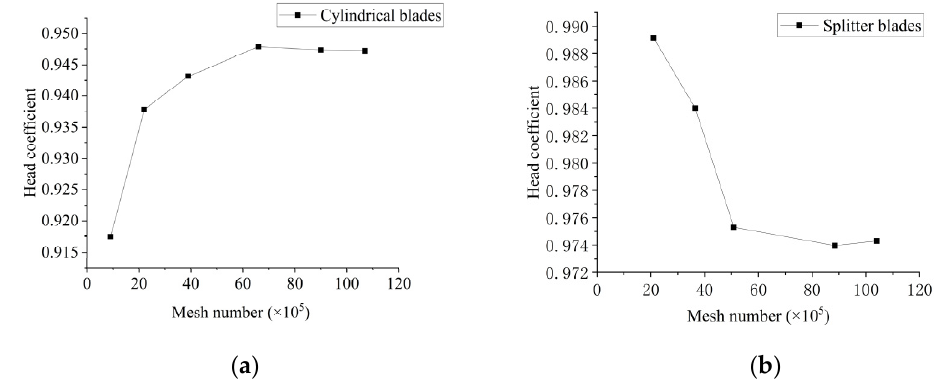
Figure 3. Verification of mesh independence: ( a ) cylindrical blades; ( b ) splitter blades.